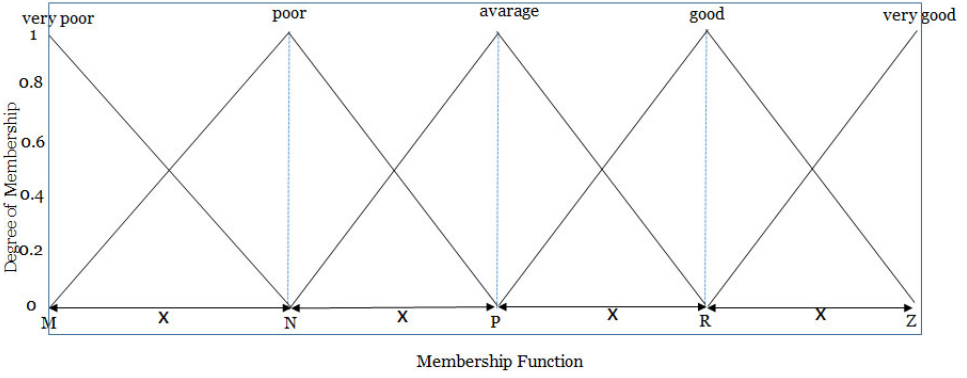
Figure 3 . Fuzzy logic system membership